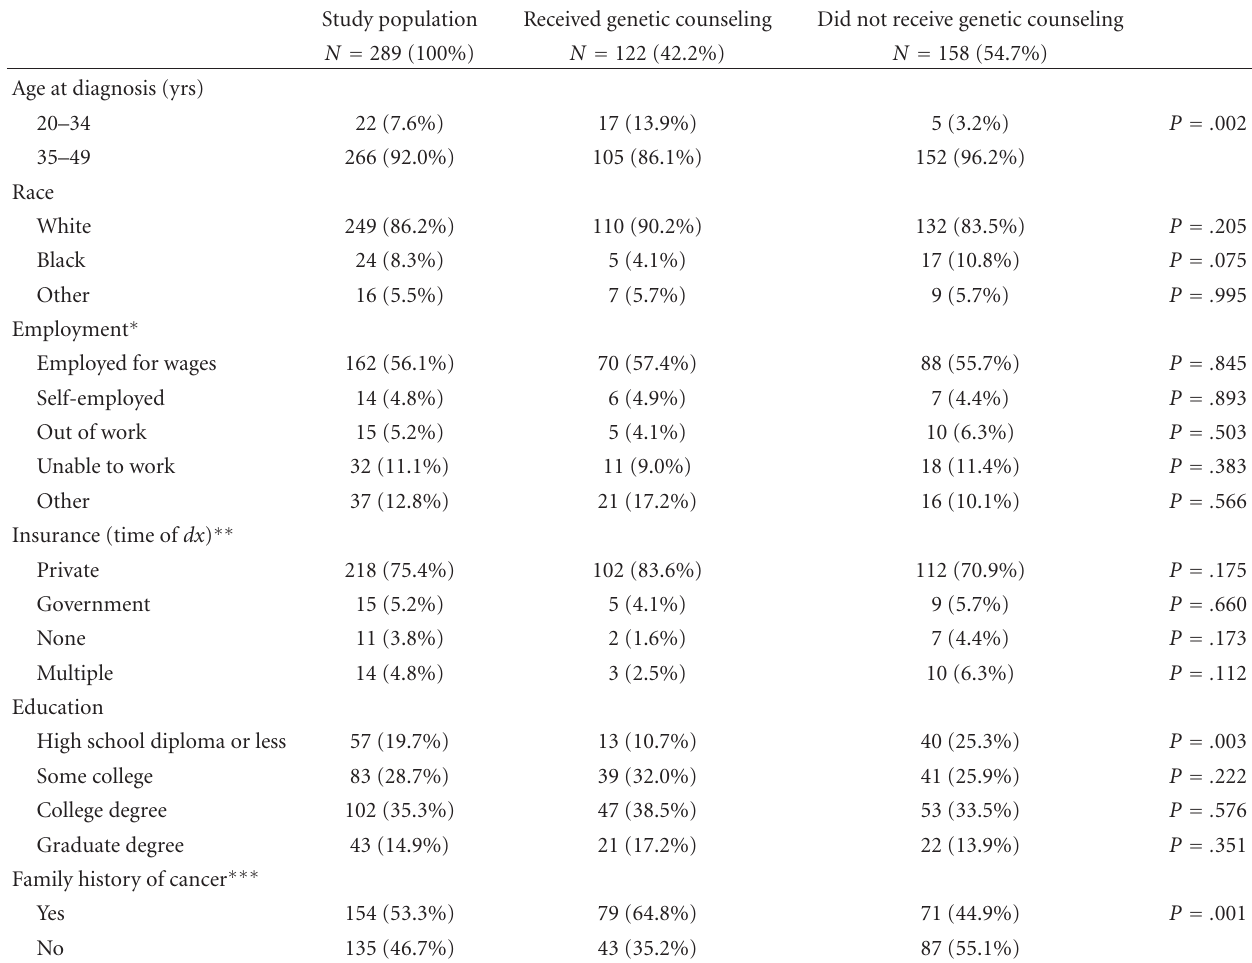
Table 2: Demographics of YBCS